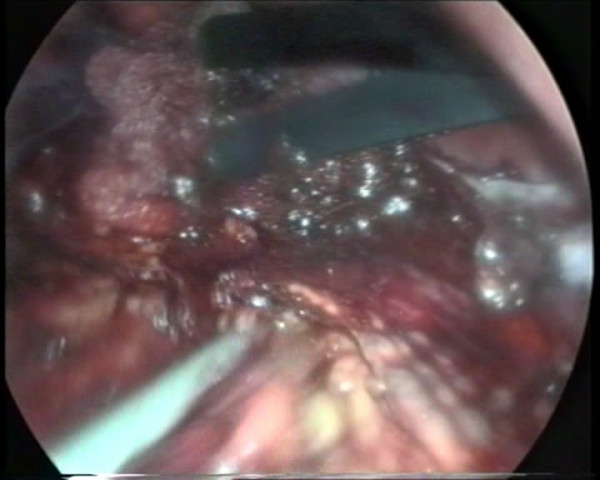
Macroscopic pigmented micronodular appearance of adrenal glands on surgery. Intra-operative view of the hyperplastic nodular adrenal glands.